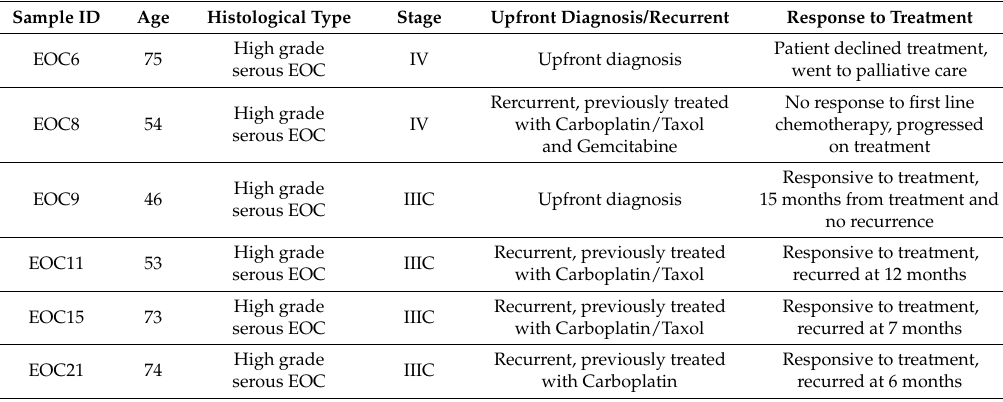
Table 1. Clinicopathological information of the ascites-derived primary EOC